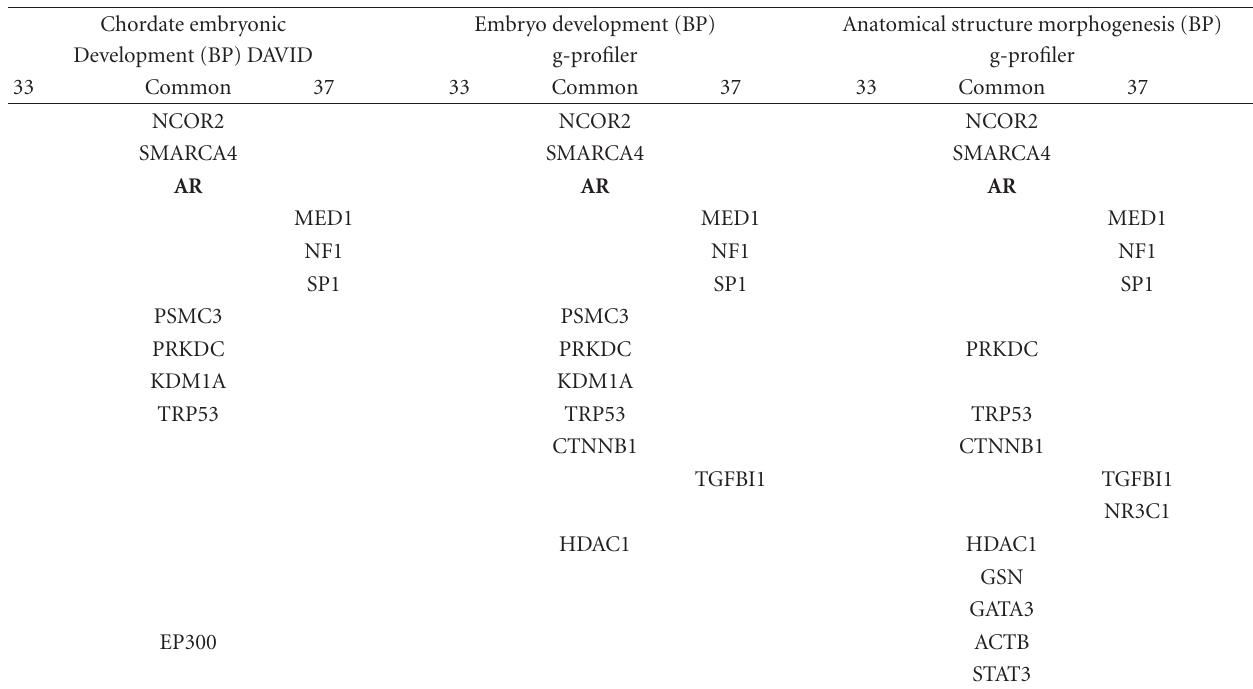
Table 4: Gene lists for the biological processes (BP) “chordate embryonic development” and “embryo development” found to be overrepresented among the known AR-interacting proteins identified in the N-TAP purifications from the 37 ◦ C samples but not the 33 ◦ C samples by the bioinformatics tool “DAVID” and “g-profiler”. Listed are the interacting proteins that were unique for the nonproliferating cells (37) and interacting proteins common to both (common). The AR is bolded. AR-interacting proteins identified only in the 33 ◦ C samples are not involved in biological processes addressed here. No counterpart for the biological process “anatomical structure morphogenesis” could be identified by